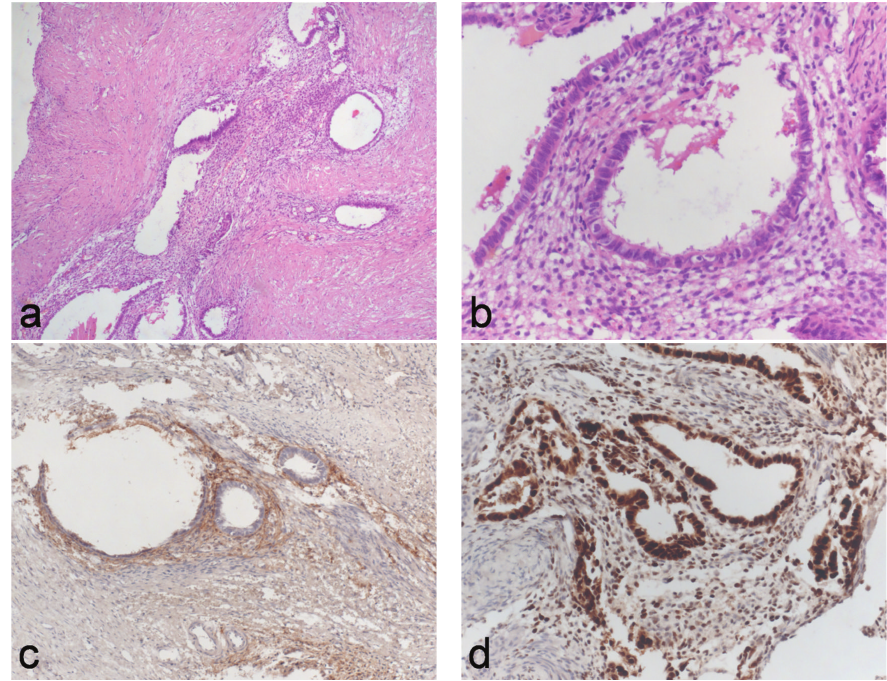
Figure4:(a)Endometrial-typeglandsembeddedinanendometrial-likestromawereevidentwithinmusculartissue(haematoxylinandeosin stain; original magnification, × 100). (b)Higher magnification of theglands, showing cylindricepithelium lining theglands (haematoxylin and eosin stain; original magnification, × 200). (c) CD10 stain in the endometrial stroma (CD10 stain; original magnification, × 100). (d) Nuclear staining for estrogen receptor in the epithelial and stromal cells of the endometriotic focus (estrogen receptor stain; original magnification, ×